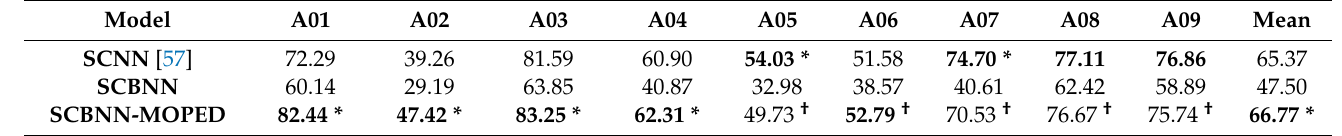
Table 4. Non-subject-specific classification results (% accuracy) on dataset 2a.